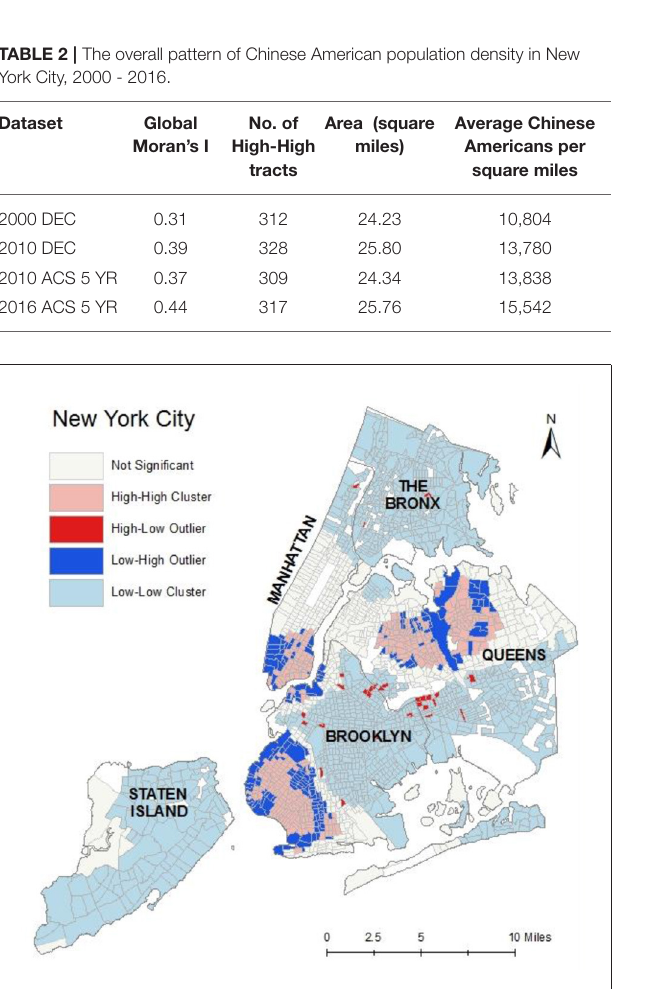
outlier. If a feature has a low value and is surrounded by features with high values, it is termed a Low-High outlier. The pink shaded areas in Figure 4 indicate Census tracts with high Chinese American population density surrounded by other areas with high Chinese American population density. These are potential locations of Chinese American enclaves, but our definition also takes into account the level of dissimilarity.